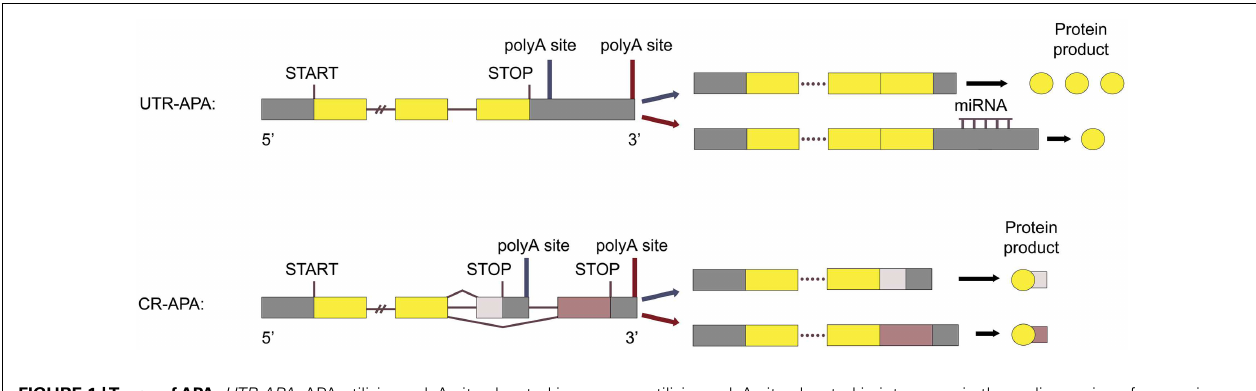
FIGURE 1 |Types ofAPA . UTR-APA: APA utilizing polyA sites located in the 3 (cid:48) UTR of the last exon is called UTR-APA and results in mRNAs with the same coding region, but with different 3 (cid:48) UTR length. CR-APA: APA